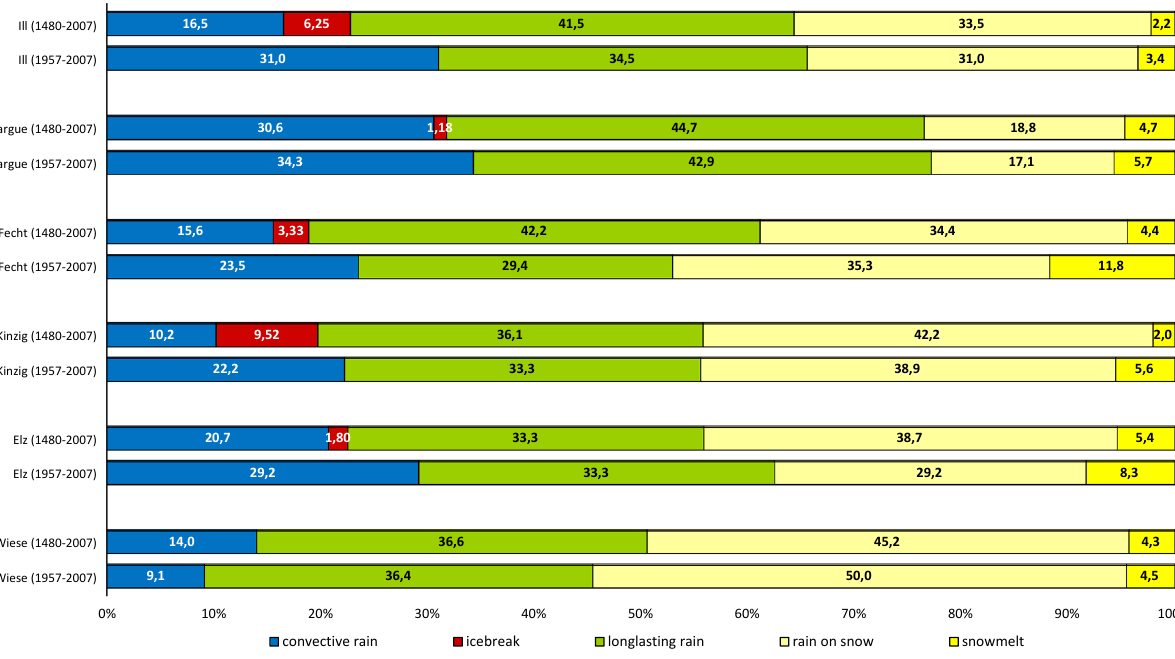
Figure 7. Changes of the meteorological causes of the floods in the last five decades in comparison to the period from 1480 to 2007.